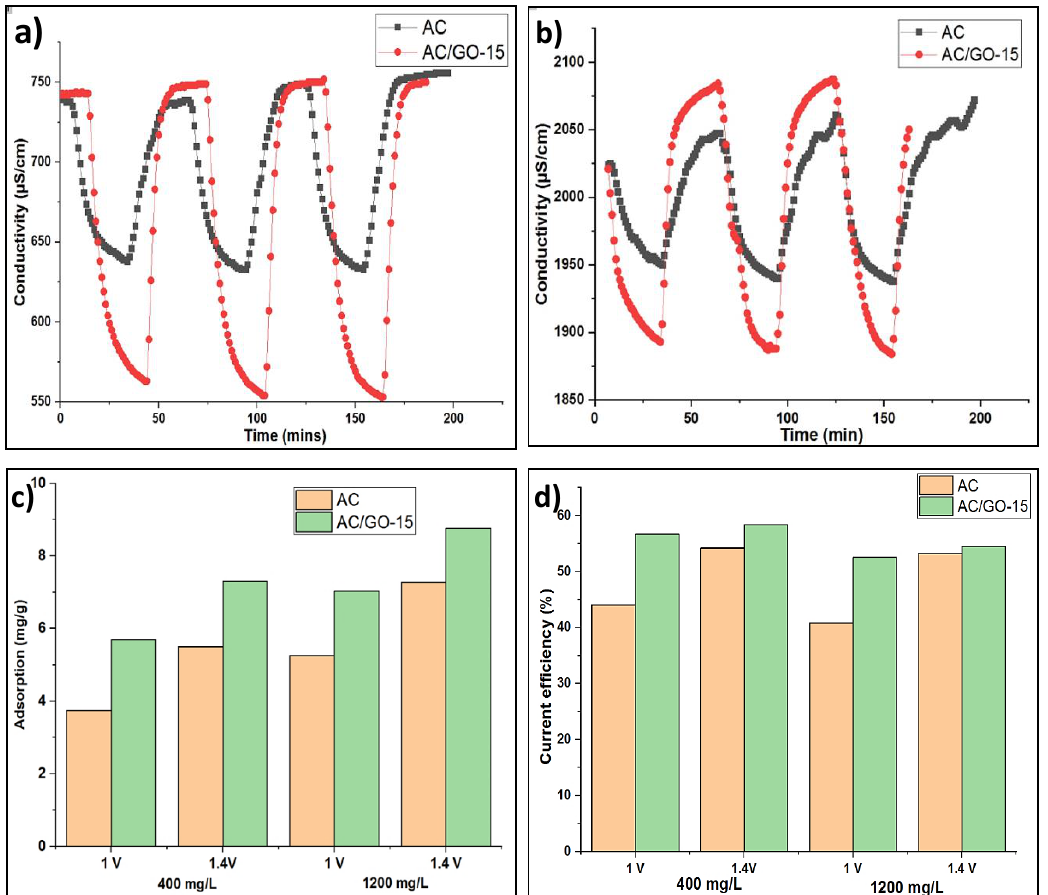
Figure 9. ( a , b ) Adsorption curves of AC and AC/GO-15 electrodes at 400 and 1200 mg/L NaCl solution. ( c ) Adsorption behavior of AC and AC/GO-15 electrodes at different NaCl concentrations and operating voltage ( d ) Current efficiency of AC and AC/GO-15 electrodes at different NaCl concentrations and operating voltage. Table 4. Electrosorption behavior of oxidized AC electrode/ doped GO electrode in CDI as found in the literature.